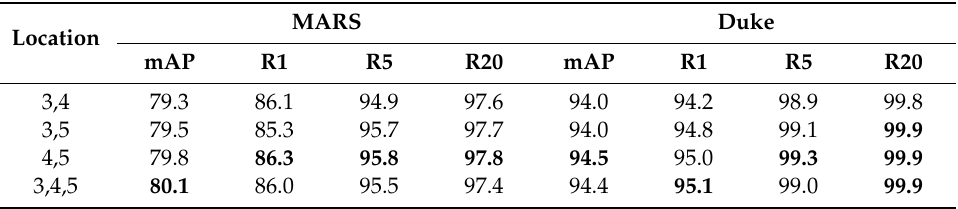
Table 4. Evaluation of the e ff ect of inserting a single NLAM layer after di ff erent CNN blocks simultaneously. The number in the location column indicates that the NLAM layer is added after these CNN blocks. For example, ‘3,4’ represents that an NLAM layer is inserted after the third and fourth CNN blocks,